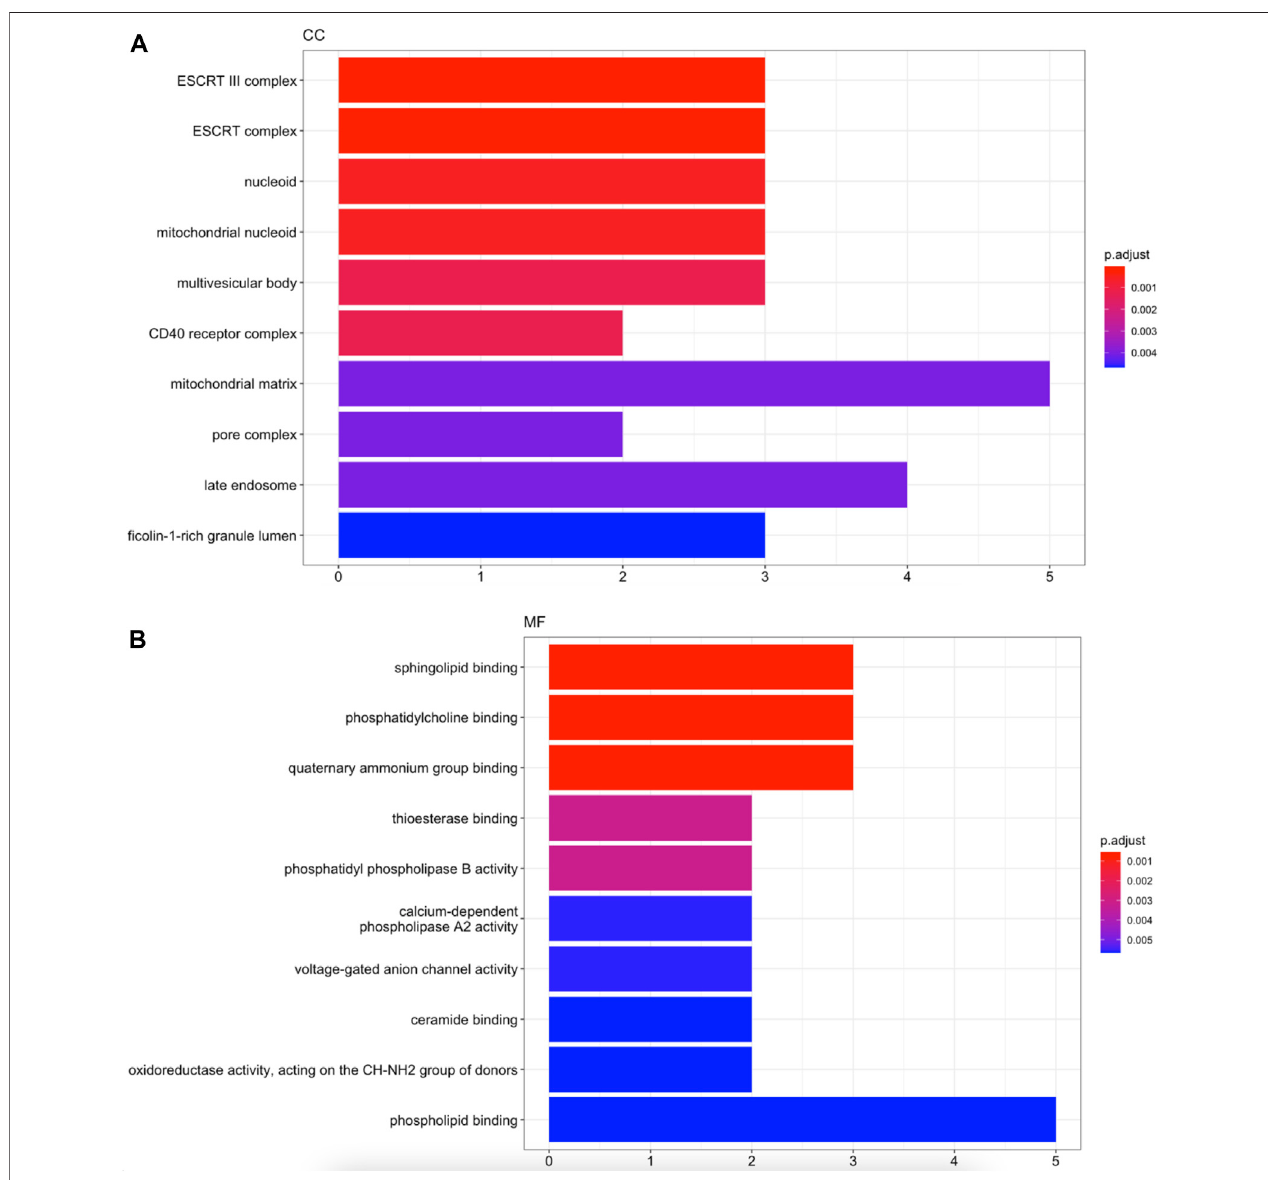
FIGURE 1 | Enrichment functions analysis in 26 necroptosis-related molecules. (A) CC analysis for 26 necroptosis-related genes. (B) MF analysis for 26 necroptosis-related genes. (C) BP analysis for 26 necroptosis-related genes. (D) KEGG enrichment analysis for 26 necroptosis-related genes.